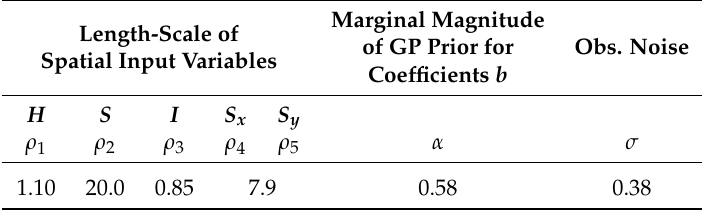
Table 2. Estimated posterior modes of the hyperparameters.